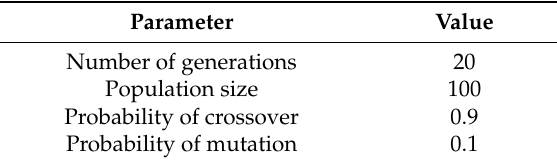
Table 6. Experimental setting used for multi-objective genetic algorithm.